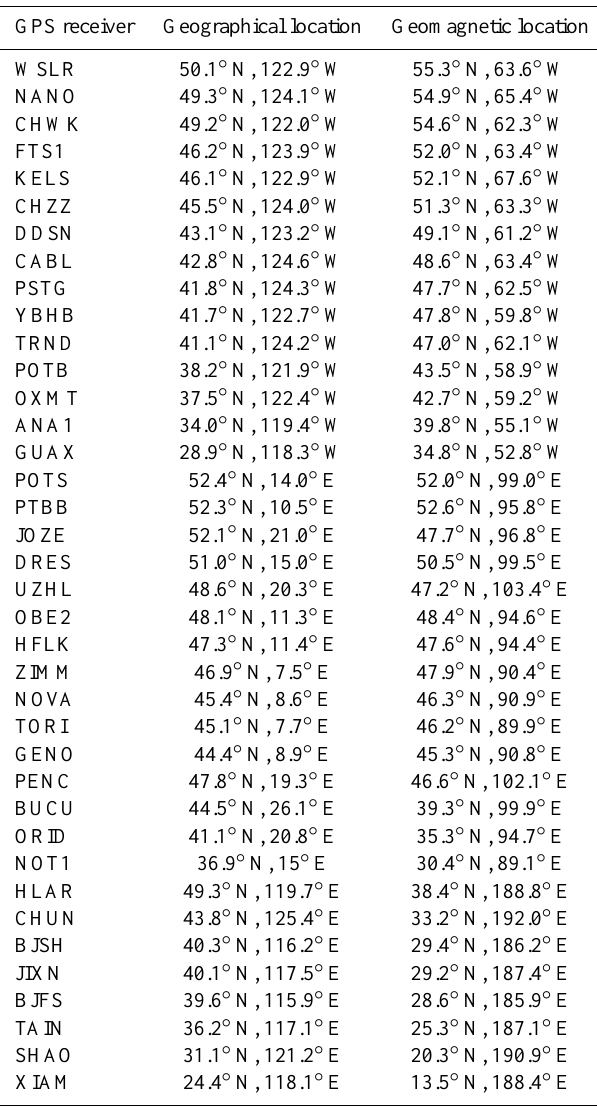
Table 1. Locations and Codes of GPS receivers used in this paper. GPS